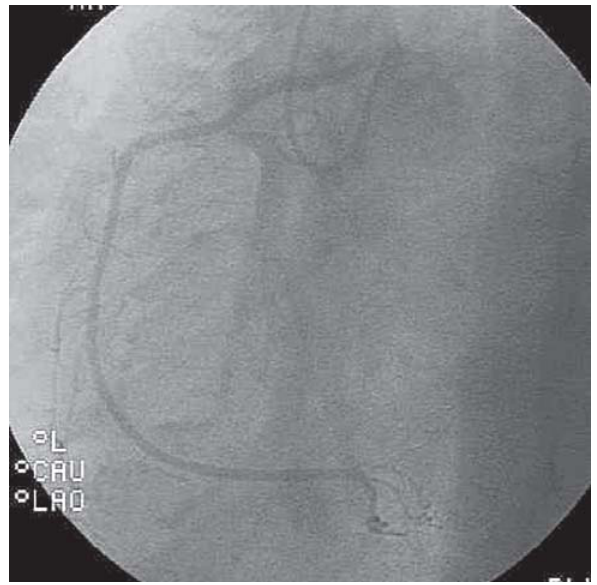
Fig. 1 - Cineangiocoronariografia da